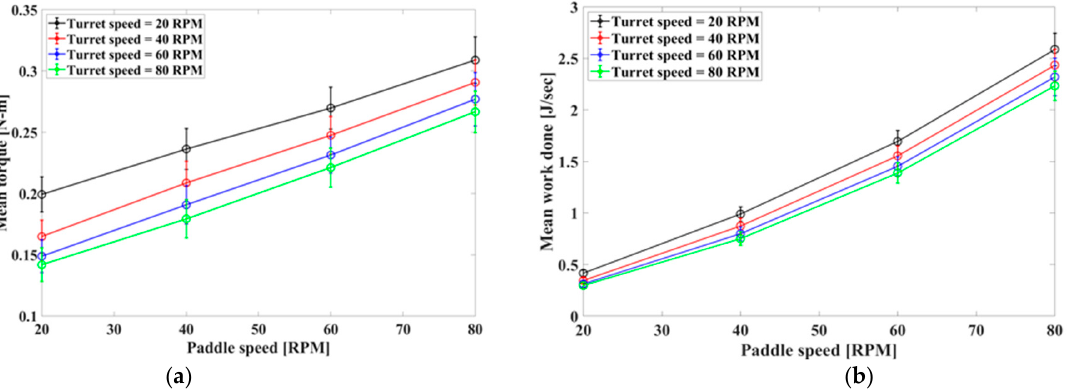
Figure 11. The effect of paddle speed and turret speed on, ( a ) the torque on the paddle wheel; ( b ) the work performed by the paddle wheel on the particles per unit of time.